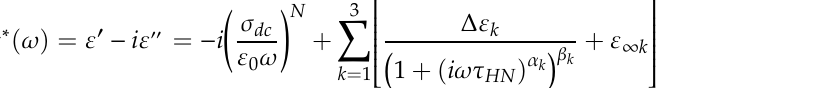
Table 2. Fit parameters of the Arrhenius equation.